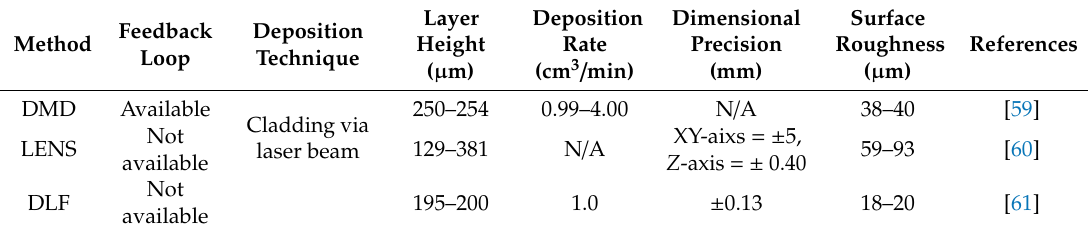
Table 2. Types of the LMD process.